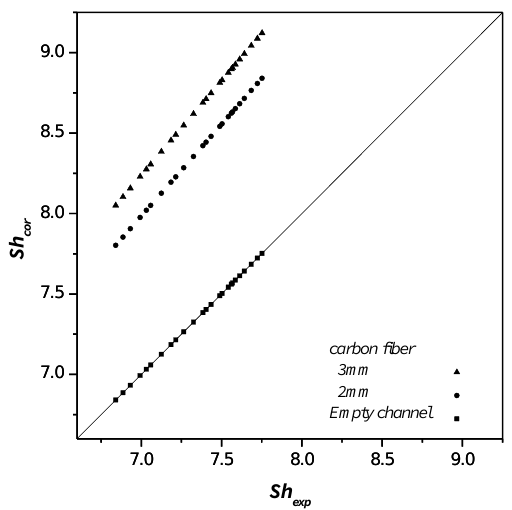
Figure 9. Comparison of calculated and experimental Sherwood numbers for the empty channel and the channels with different widths of carbon-fiber spacers.